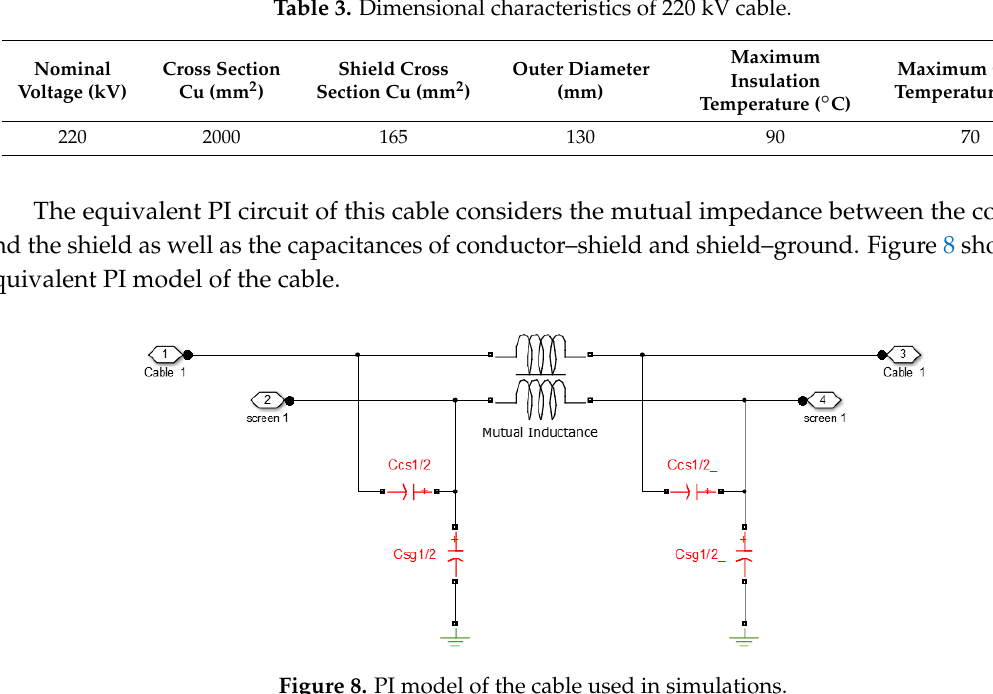
Table 4. Characteristics of 220 kV overhead line.